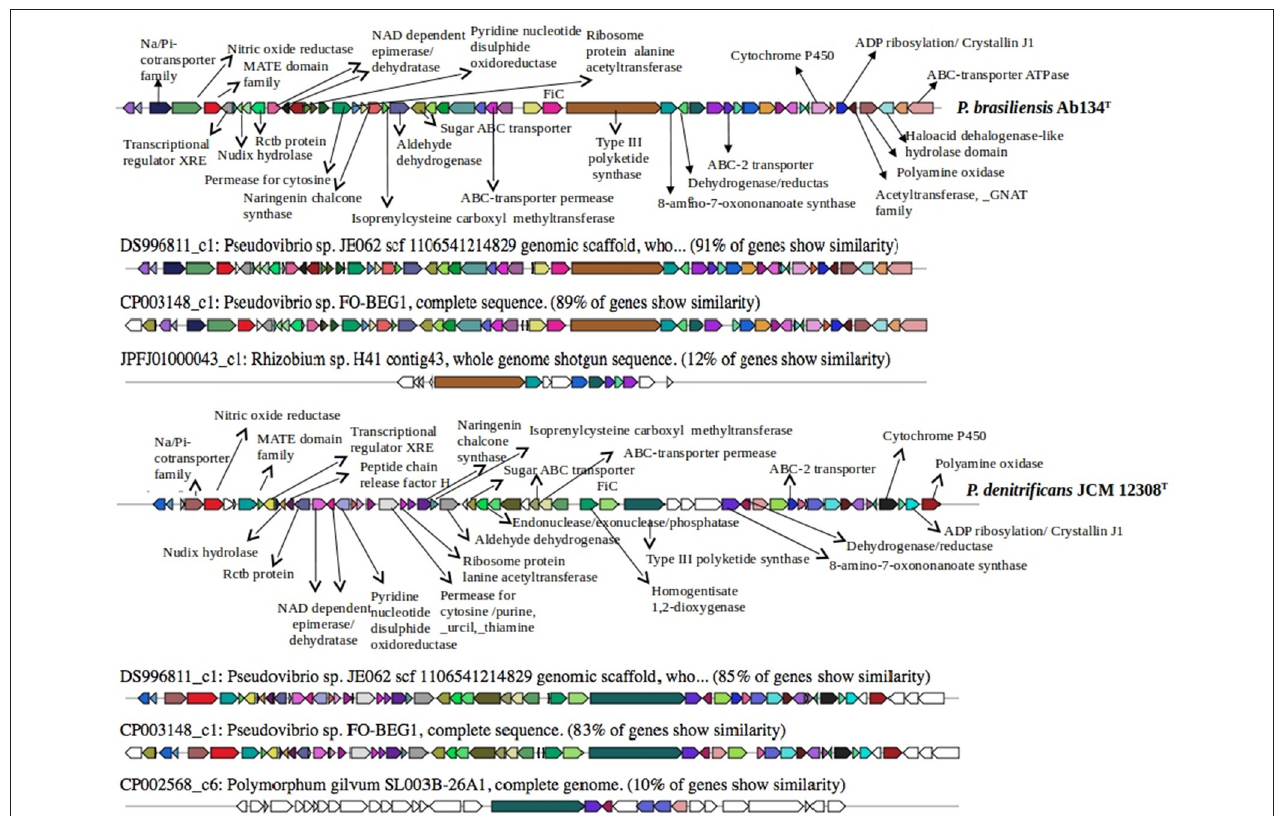
FIGURE 2 | PKS3-PKS1 pathway cluster identified in the P . brasiliensis Ab134 T genome and in the P. denitrificans JCM 12308 T